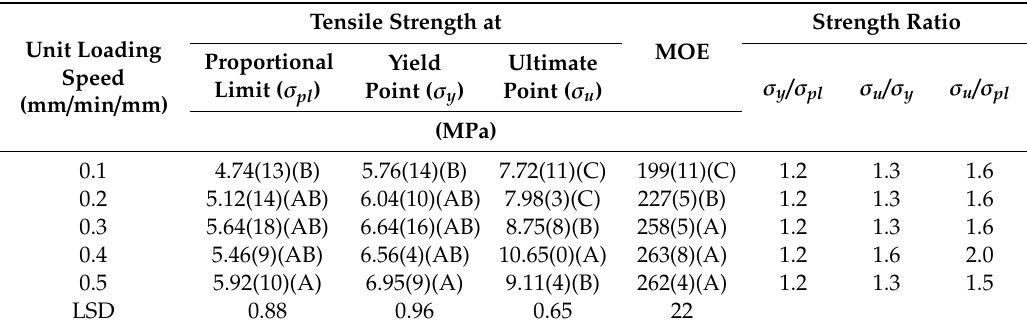
Table 7. Mean values of tensile strength and modulus of elasticity (MOE) of synthetic rattan strips tested in test 3 and their corresponding mean comparisons for unit loading speed 1 .